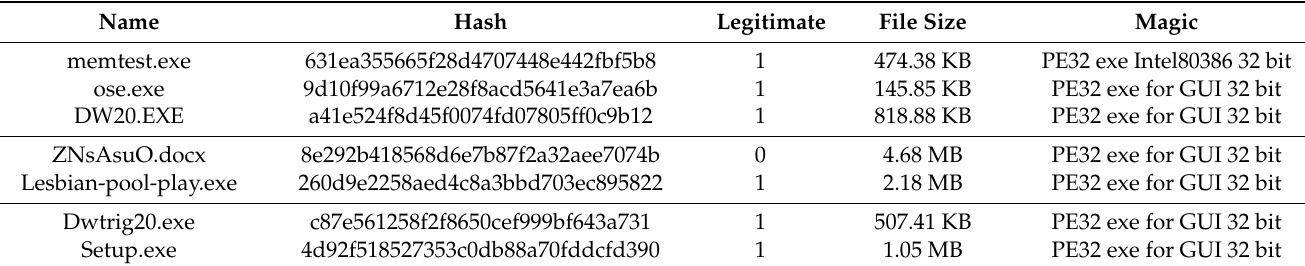
Table 2. Malicious code analysis and feature extraction results (partial).